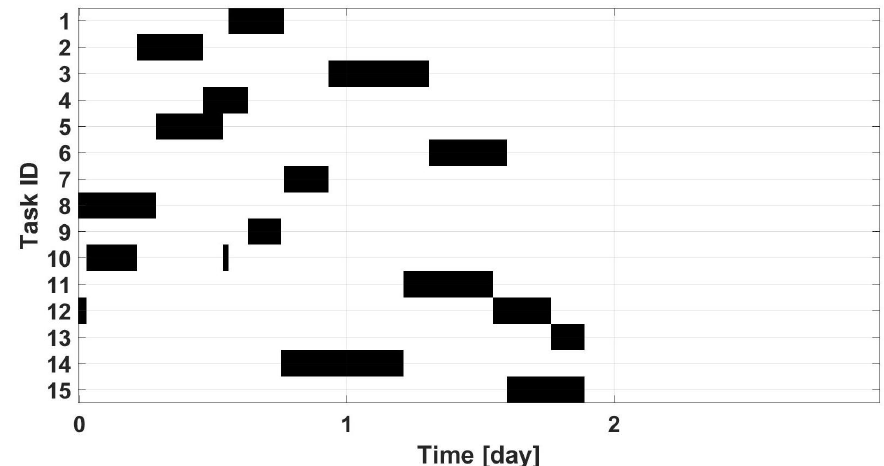
Figure 5. Tasks Planning Simulation